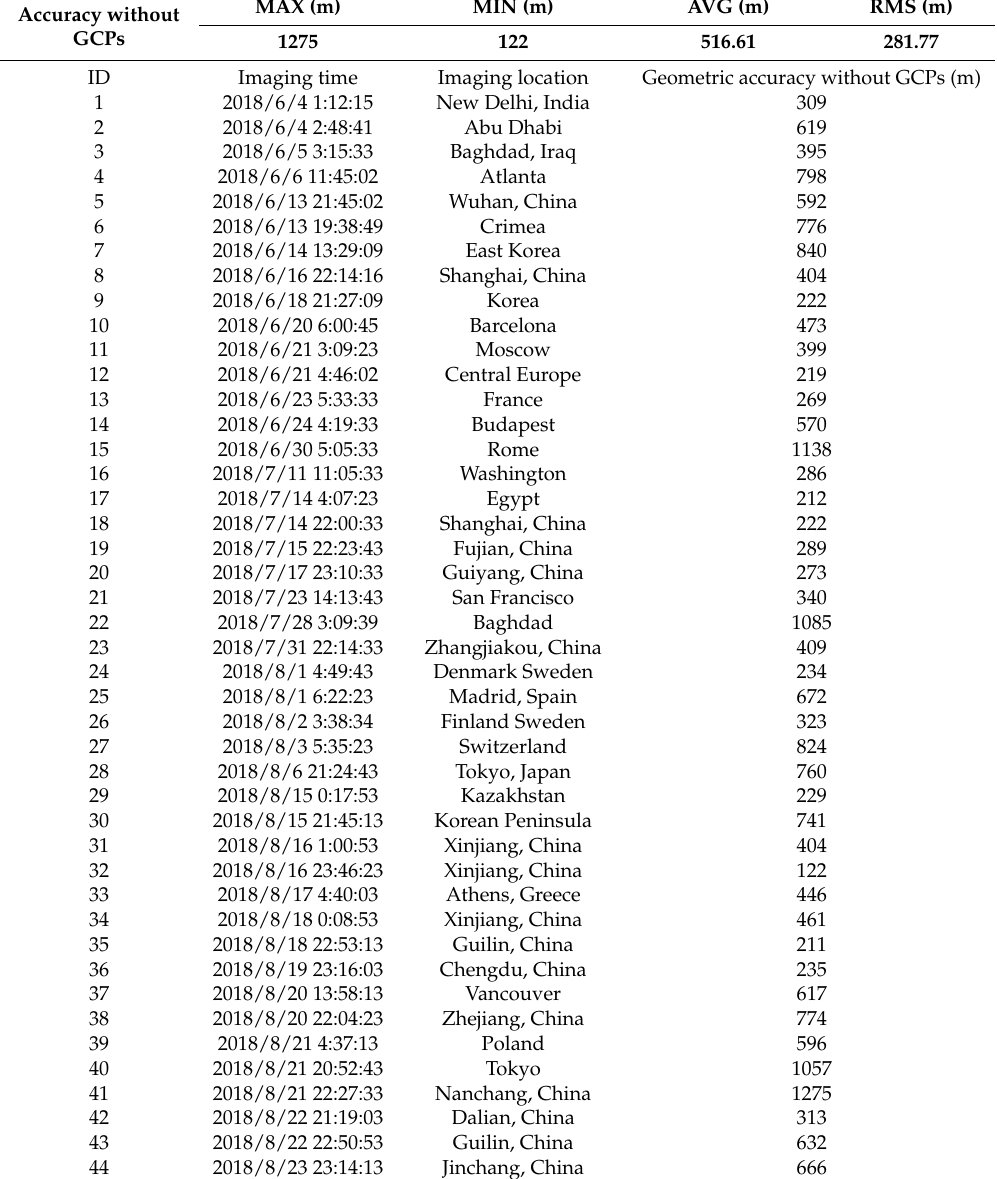
Figure 11. Accuracy without geometric control points (GCPs) change in June–August. Table 5. Accuracy of statistics without GCPs of LJ1-01 in June–August.